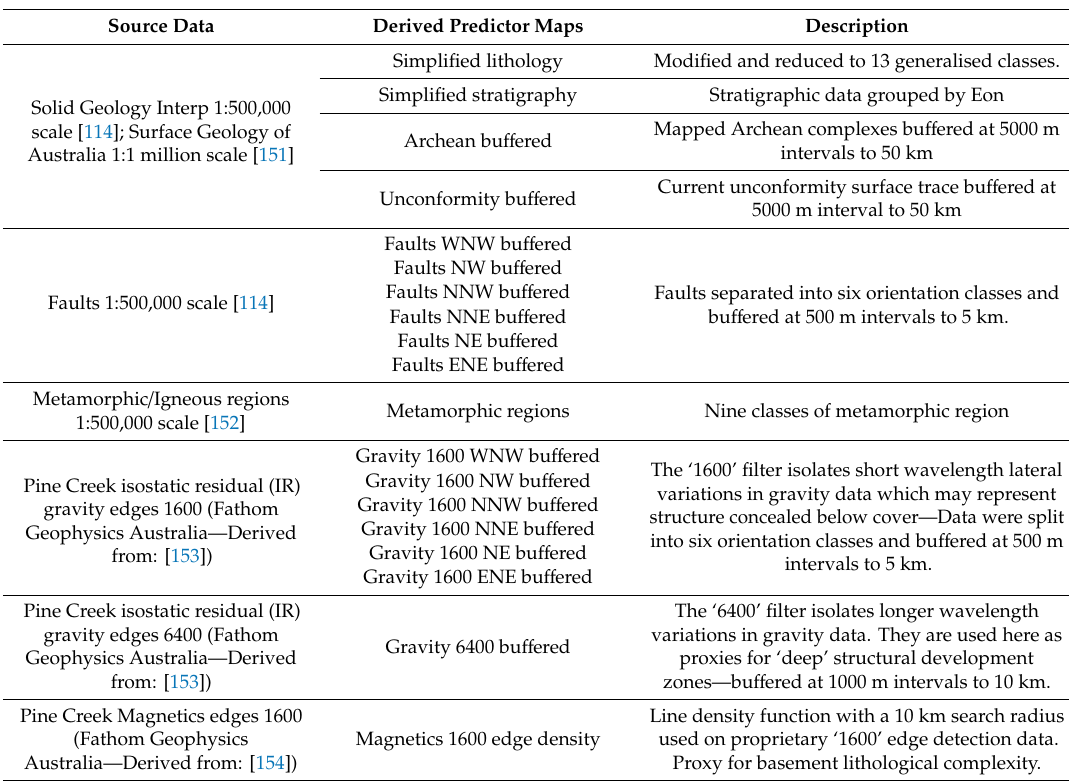
Table 2. Source data and predictors for the NW McArthur Basin MPM. The listed data are available from the Northern Territory Geological Survey’s ‘Geoscience Exploration and Mining Information System (GEMIS)’, Geoscience Australia’s online Product Catalogue or the Geophysical Archive Data Delivery System (GADDS) on the Australian Government’s Geoscience